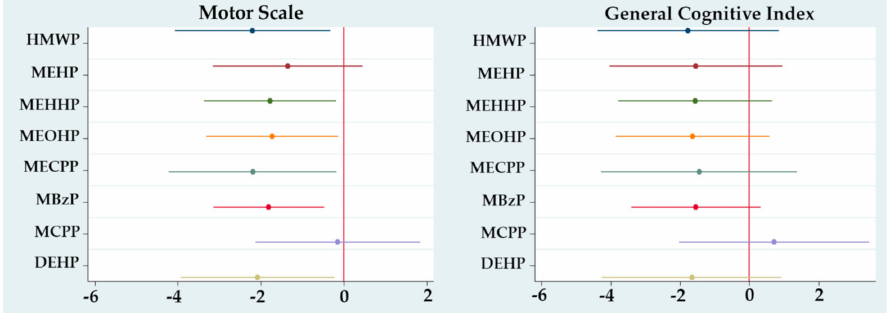
Figure 2. Regression coe ffi cients for change in McCarthy Scales of Children’s Abilities (MSCA) associated with a second trimester ln-unit increase in urinary phthalate metabolite concentration, adjusted for sex, gestational age, breastfeeding and maternal IQ. *Motor Scale: MEHP and MCPP p > 0.05; General Cognitive Index: all metabolites p > 0.05.